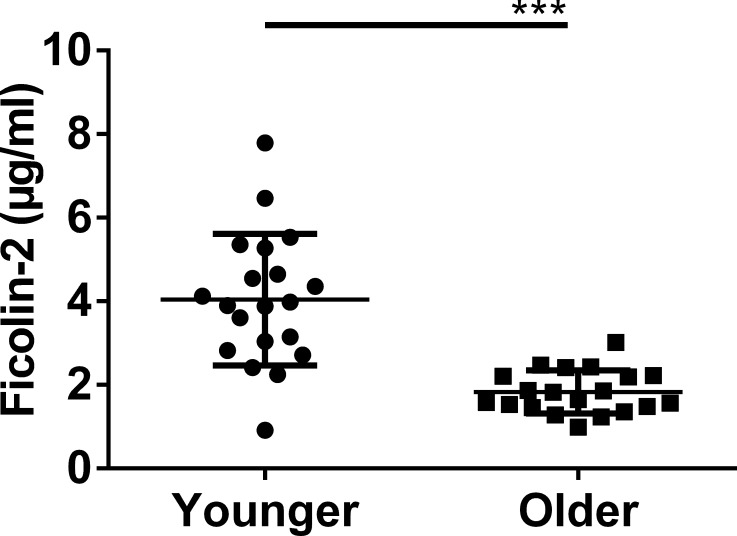
Archived older adults’ sera are significantly reduced in ficolin-2 content relative to healthy young controls.Twenty sera were selected at random from UAB Study of Aging archived sera and assayed for ficolin-2 by a commercial ELISA (“Older”). Each data point is shown along with mean and standard deviation. ***, P < 0.001 by unpaired t-test assuming unequal variances. Values for young, healthy controls (“Younger”) were previously reported by our laboratory (Brady et al., 2014a) and used here with permission.